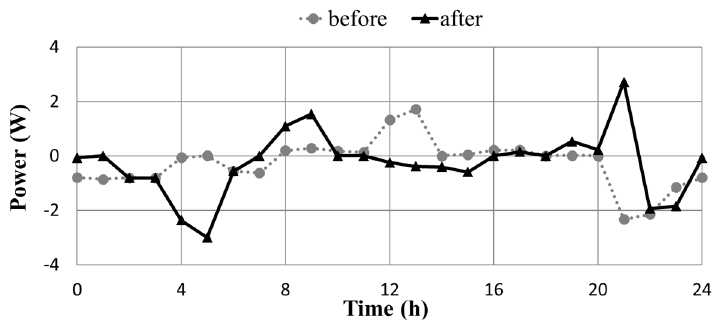
Figure 6. Power at the point of delivery before and after the prosumer problem solution.